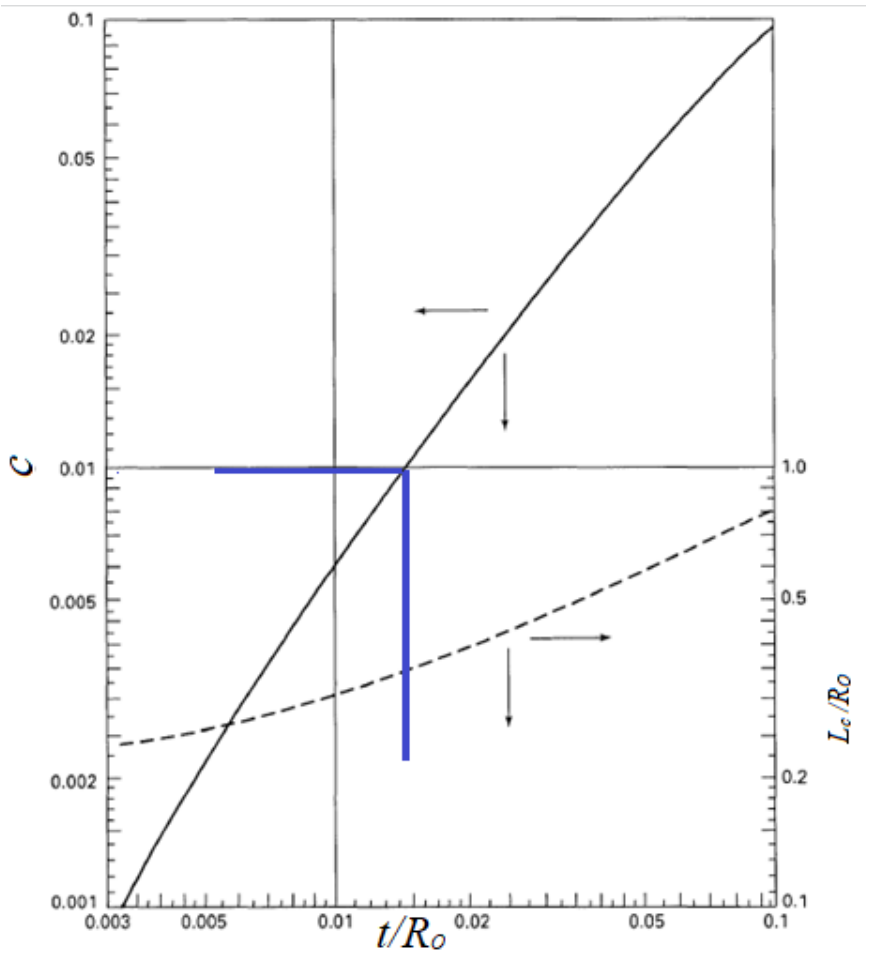
Figure 8. Values of t Engineers, 2007.